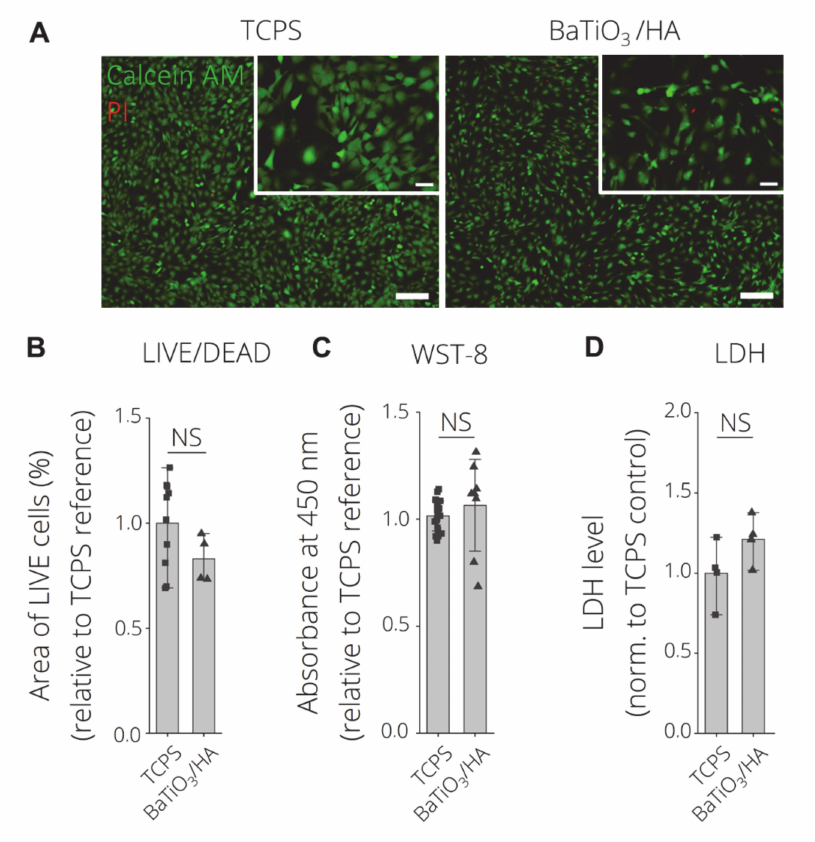
Figure 9. Indirect in-vitro cytotoxicity test according to ISO 10993 using material eluates. ( A ) LIVE / DEAD Images of Calcein AM (green, live) and propidium Iodide (red, dead) stained MC3T3-E1 cells after 24 h of incubation on tissue culture polystyrene (TCPS) with cell culture medium (pos. control), BaTiO 3 / HA sca ff olds eluates. Scale bars: 200 µ m, 50 µ m (detail). ( B ) Quantification of LIVE / DEAD data as area of live cells (%) per FM image (n > 4 biological replicates, n = 3 images) normalized to TCPS reference substrates. ( C ) Indirect cell viability test (WST-8) (n ≥ 4 biological replicates) measured as the absorbance at 450 nm as an indicator for cell viability. ( D ) Intracellular LDH level as a measure of cell death and proliferation (n = 4 biological replicates). Data are shown as mean ± SD. Statistically significant di ff erences were analyzed using one-way ANOVA analysis, with no significant di ff erence indicated